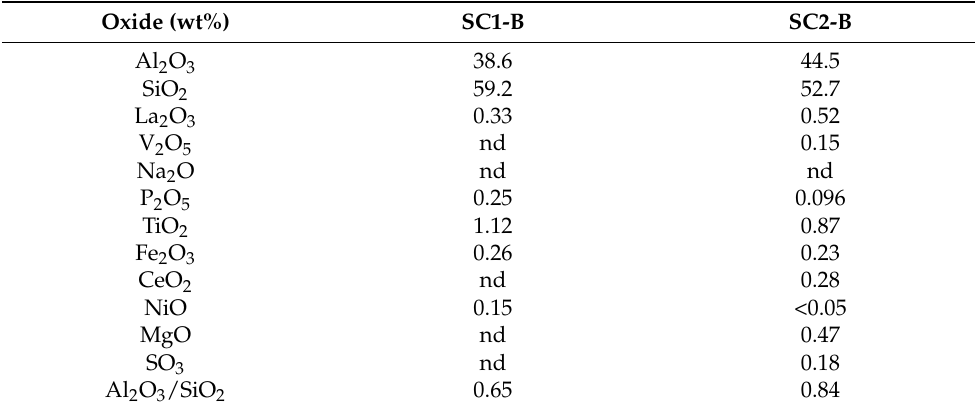
Table 4. Chemical compositions (wt%) for both spent FCC insoluble residue powders.